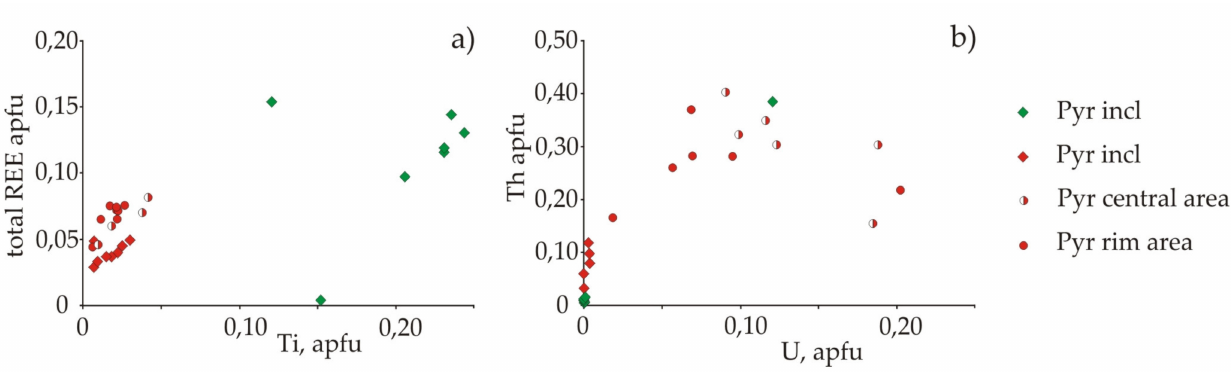
Figure 10. Variation of pyrochlore compositions from Arbrastakh phoscorites ( a ) REE vs. Ti; ( b ) Th vs.